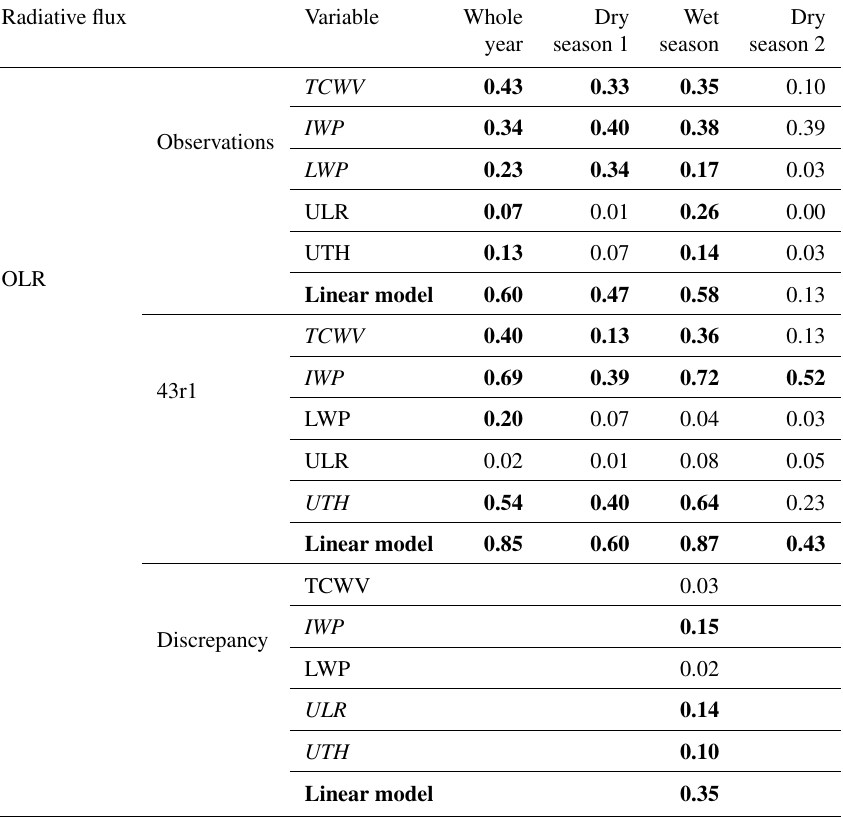
Table 8. TOA OLR fluxes: r 2 values from correlations between observed and 43r1 OLR, and their discrepancy, to other variables for the significant (to p ≤ 0.001) values are in bold. Italics indicate which variables were used in the linear model. Radiative flux Variable